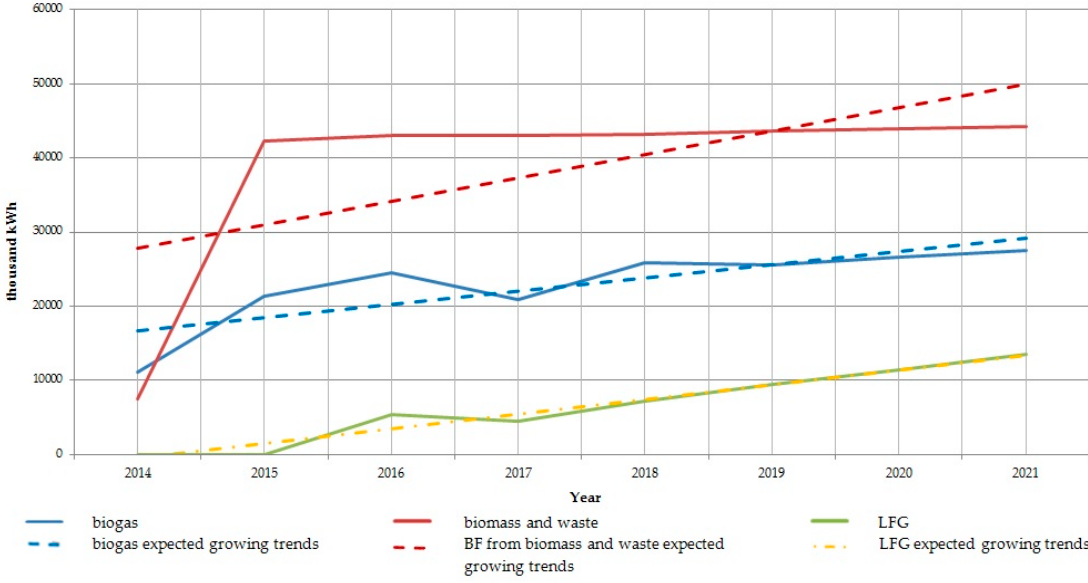
Figure 7. Forecasting of certificates confirmed electricity production by qualified renewable energy facilities (retail and wholesale markets), 2014–2021, thousand kWh [131,194].